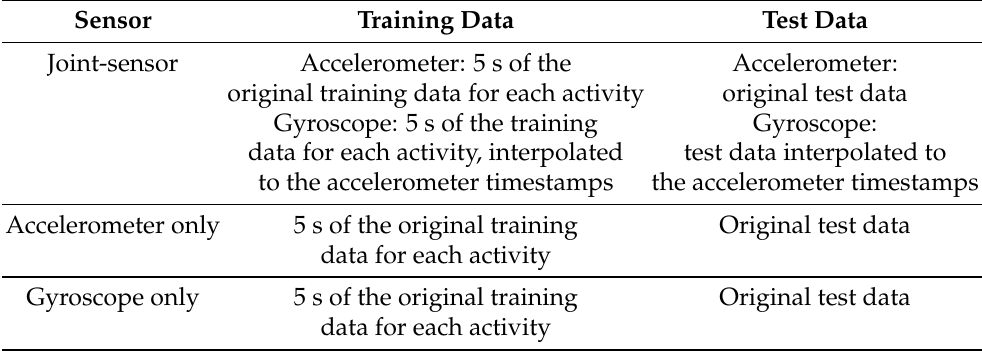
Table 1. Analysis procedure. This table summarizes the analysis procedure of this paper. The rows of the table show the methods, including the joint-sensor method, the accelerometer-only method, and the gyroscope-only method. For each method, the “Training Data” column indicates the amount of training data used per activity, and whether linear interpolation was applied to the data. For each participant’s training data, we used 5 s per activity, with the exceptions of the sit-to-stand and stand-to-sit transitions. The “Test Data” column indicates whether linear interpolation was applied to the test